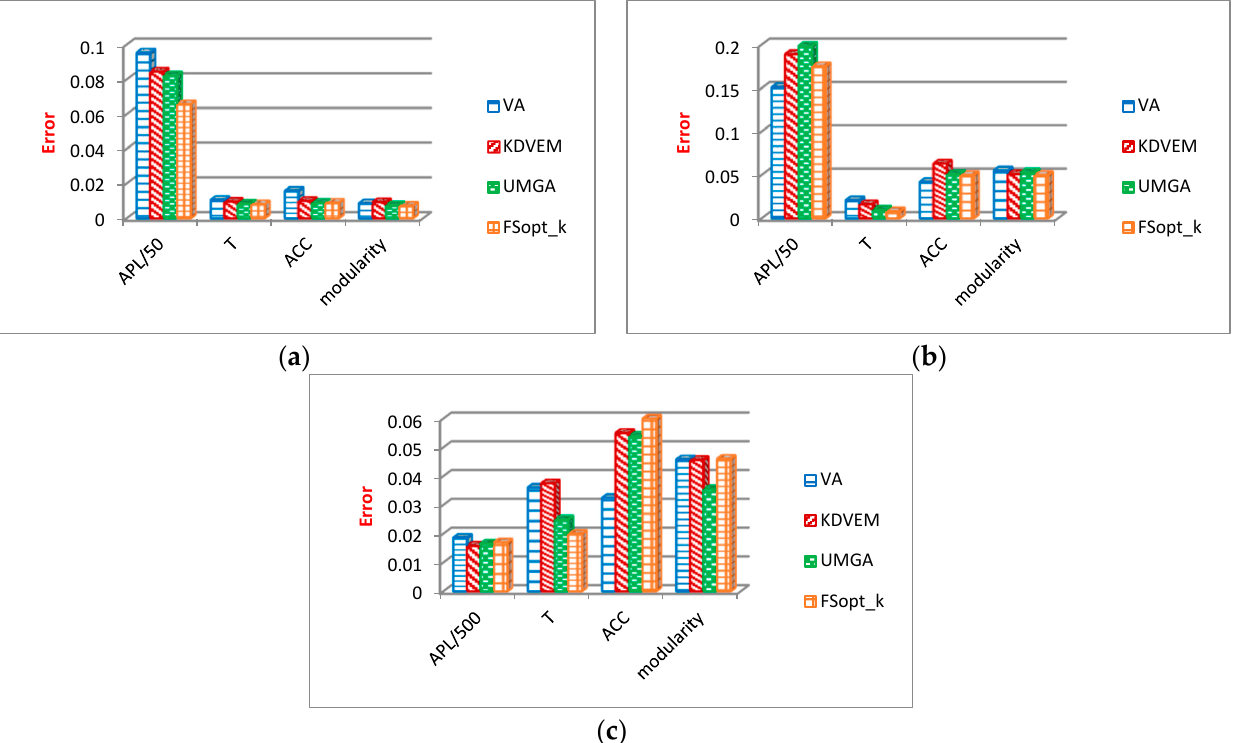
Figure 11. Comparison of error values of the algorithms on polbooks dataset for (a): ℒ = 0.05 , (b): ℒ = 0.1 , and (c): ℒ = 0.2 .